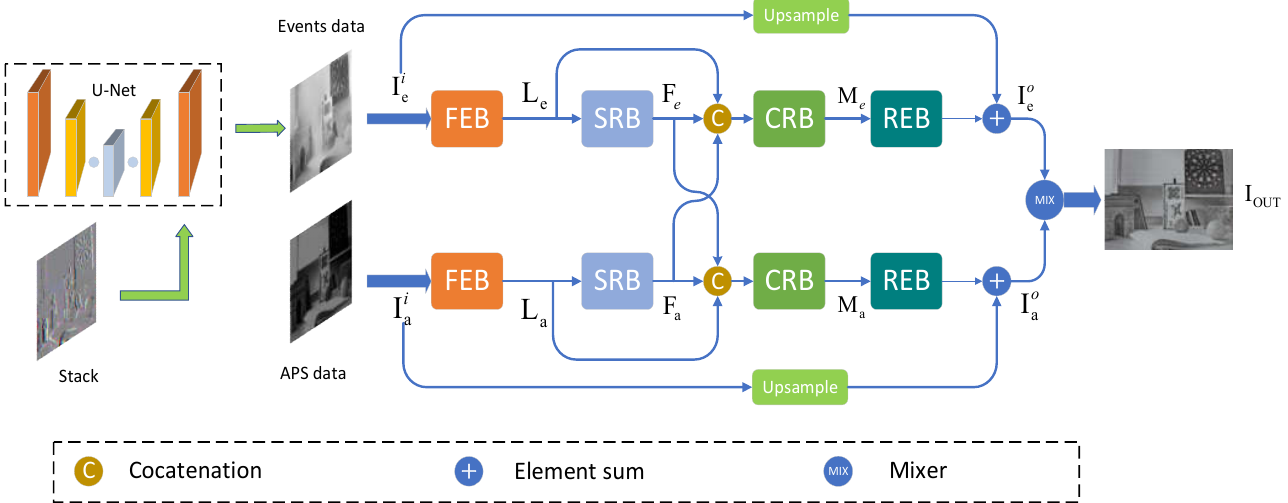
Figure 3. EFSR-Net network structure. The event data is first preprocessed to form a stack, followed by a series of encoding and decoding through the network. The processed event information and APS frame information are used as inputs into the upper and lower coupling sub-networks. Each sub-network consists of a feature extraction block (FEB), a coupled response block (CRB), and a reconstruction block (REB). The final super-resolution image reconstruction is achieved by the mixer (MIX) convolutional network.